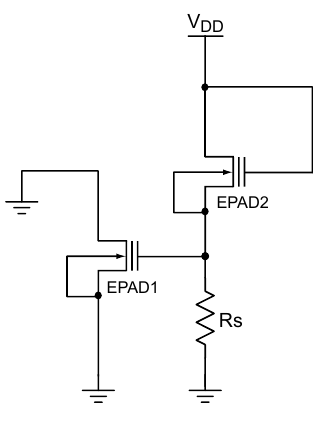
Figure 8. Idea of self-compensated dynamic